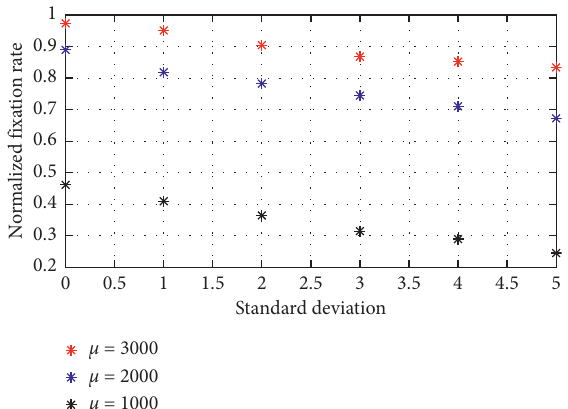
Figure 5: The relationship between the fixation rate of the focal and the value of the standard deviation of the expression allele A 1 time t ′ , in case of nonsynchronous expression for different ex- pression